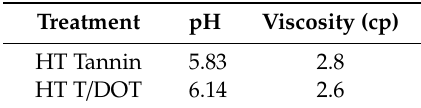
Table 1. pH and viscosity of treating solutions. HT: heat treatment; T / DOT: tannins / disodium octaborate